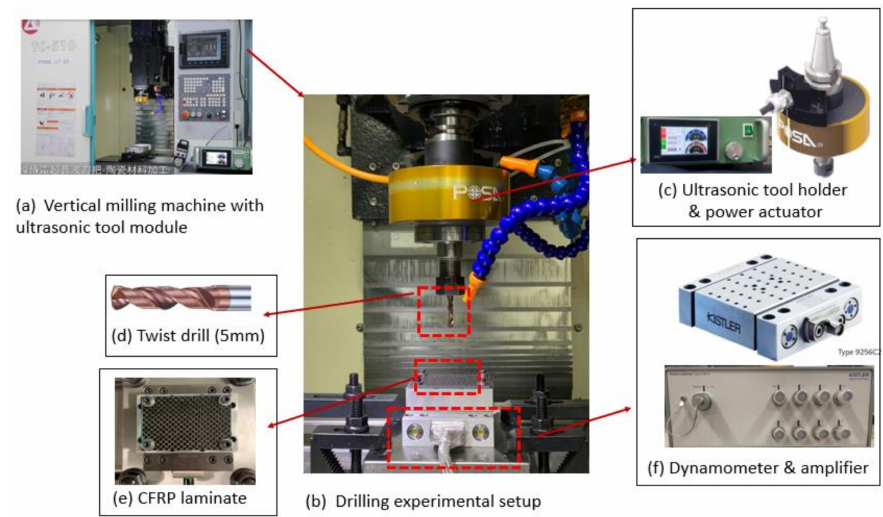
Figure 1. Experimental configuration: ( a ) vertical milling machine with ultrasonic tool module, ( b ) ultrasonic drilling experimental setup, ( c ) ultrasonic tool holder and power actuator, ( d ) twist drill, ( e ) CFRP workpiece, and ( f ) dynaometer with amplifier for measuring the cutting force.